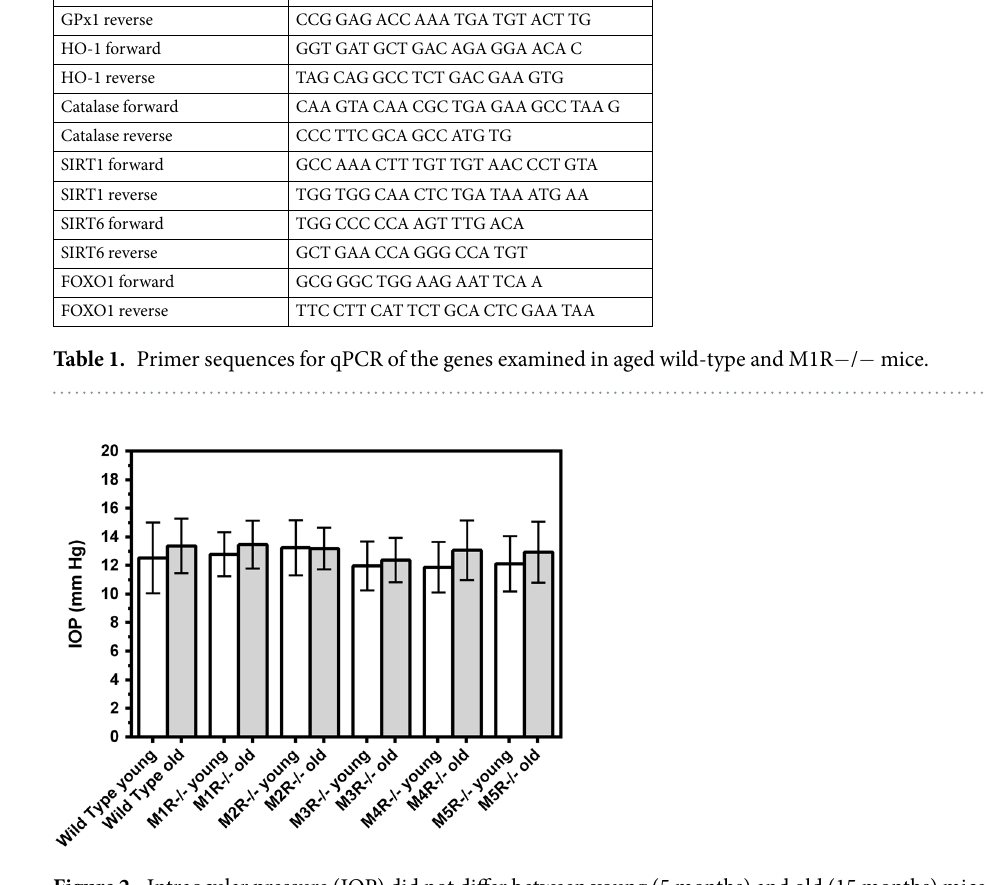
Figure 2. Intraocular pressure (IOP) did not differ between young (5 months) and old (15 months) mice in any of the mouse groups. Also, no differences in IOP were seen between individual mouse genotypes of the same age category. Data are presented as mean ± SD (n = 8 per age category and